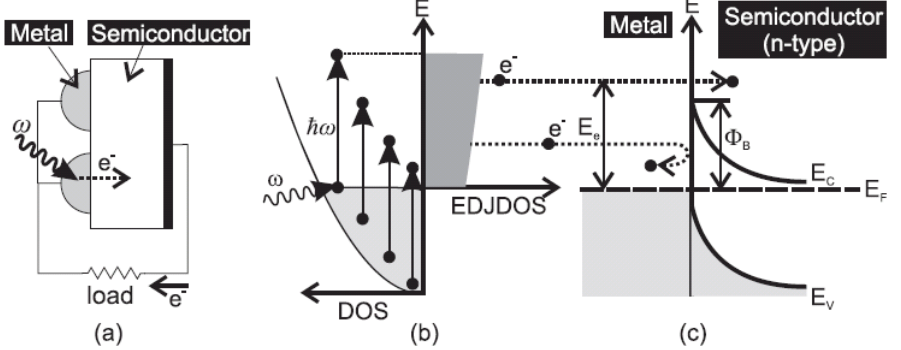
Figure 11. ( a ) Geometry of a plasmon-enhanced internal photoemission solar cell. ( b ) Excitation of electrons in the metal from occupied energy levels in the conduction